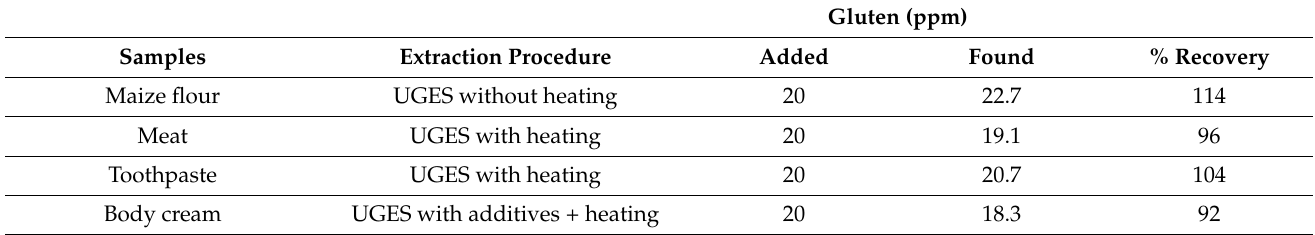
Table 4. Gluten recovery in commercial samples labeled gluten-free and spiked using lateral flow immunochromatographic assay